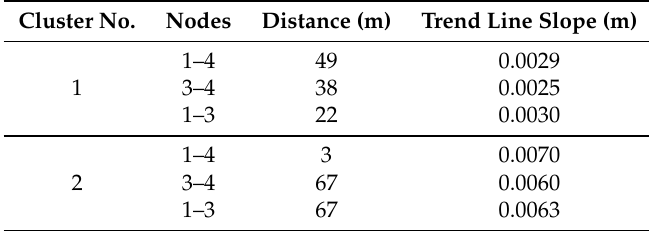
Table 5. Example of distances and trend lines slopes of pairs of nodes for clusters 1 and 2 of Arcetri Test Site. Cluster No. Nodes Distance (m) Trend Line Slope